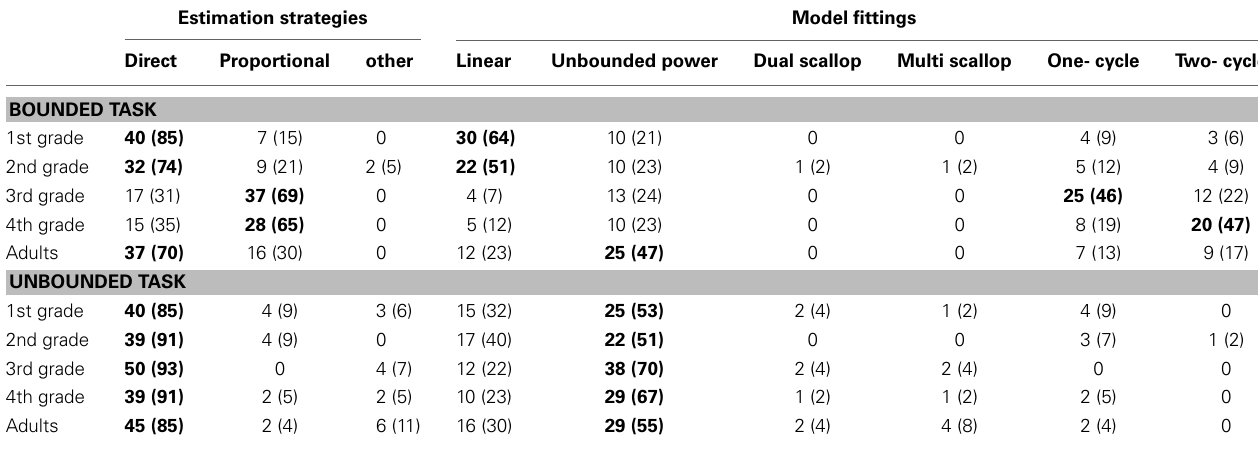
Table 1 | Absolute and relative frequency (percentages) of best fitting models indicating direct estimation, proportion judgments or other estimation strategies (left column) and detailed distribution of best fitting model of participants’ estimates (right column) separated for bounded and unbounded number line tasks and age